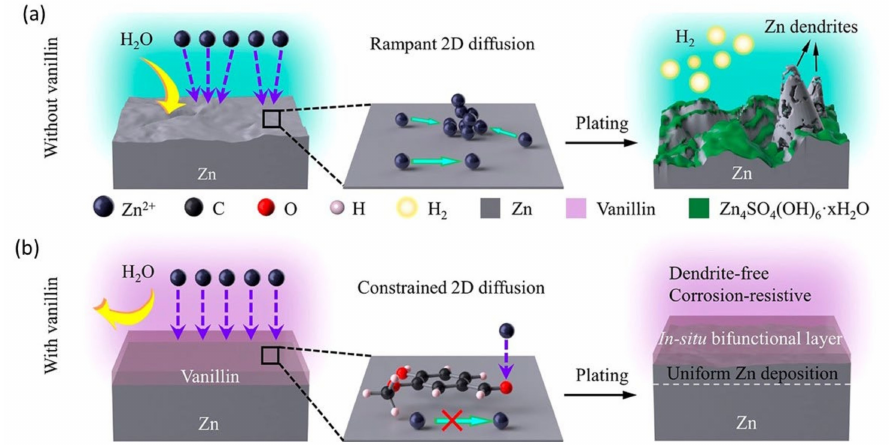
Figure 4. Schematics and bifunctional mechanism of vanillin sustaining Zn electrochemistry: Zn 2+ diffusion/adsorption and Zn plating characteristics in ( a ) vanillin-free and ( b ) vanillin-containing aqueous ZnSO 4 electrolytes are depicted schematically. Reprinted with permission from Ref. [55]. Copyright 2021 American Chemical